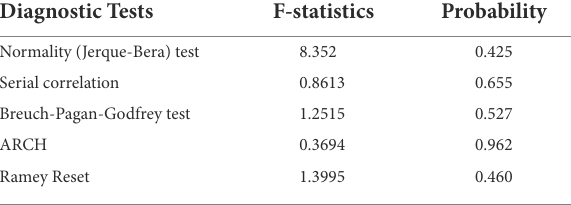
TABLE 7 Diagnostic tests for the NARDL model.